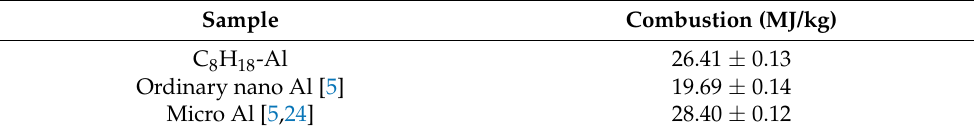
Table 3. Combustion heat of samples.